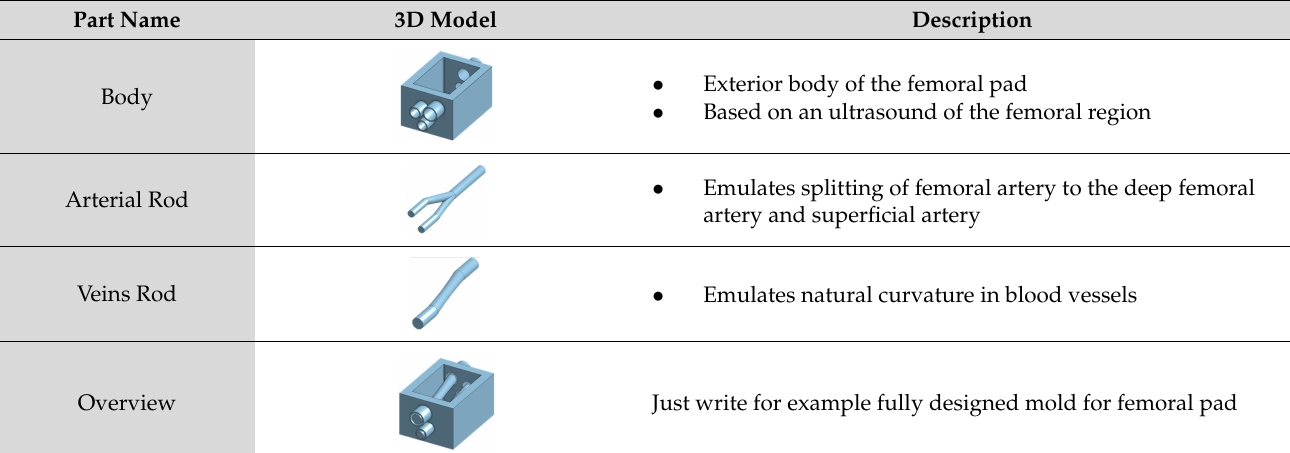
Table 2. Design of the femoral pad mold.